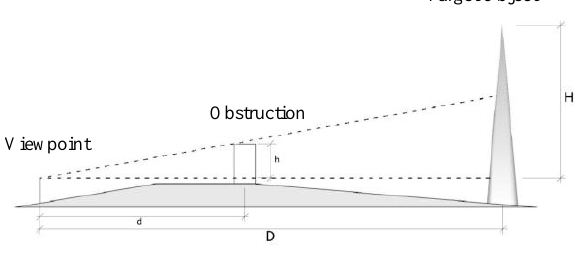
Figure 1. Calculating principles of covered scene analysis The formula of covered relationship